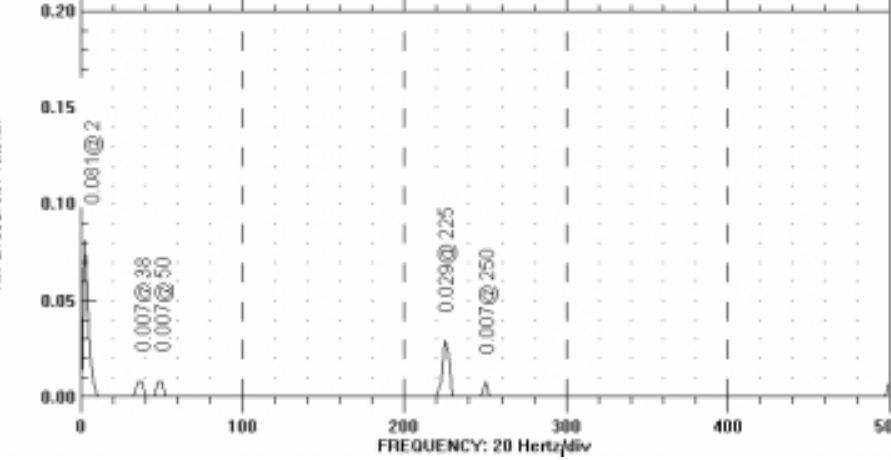
Fig. 29. Frequency spectrum of the strain gage signal for the free vibration test.